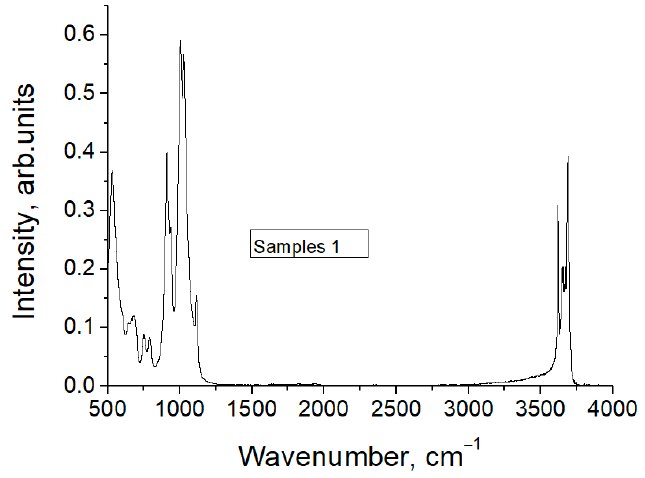
Figure 3. Average overview spectrum of dry